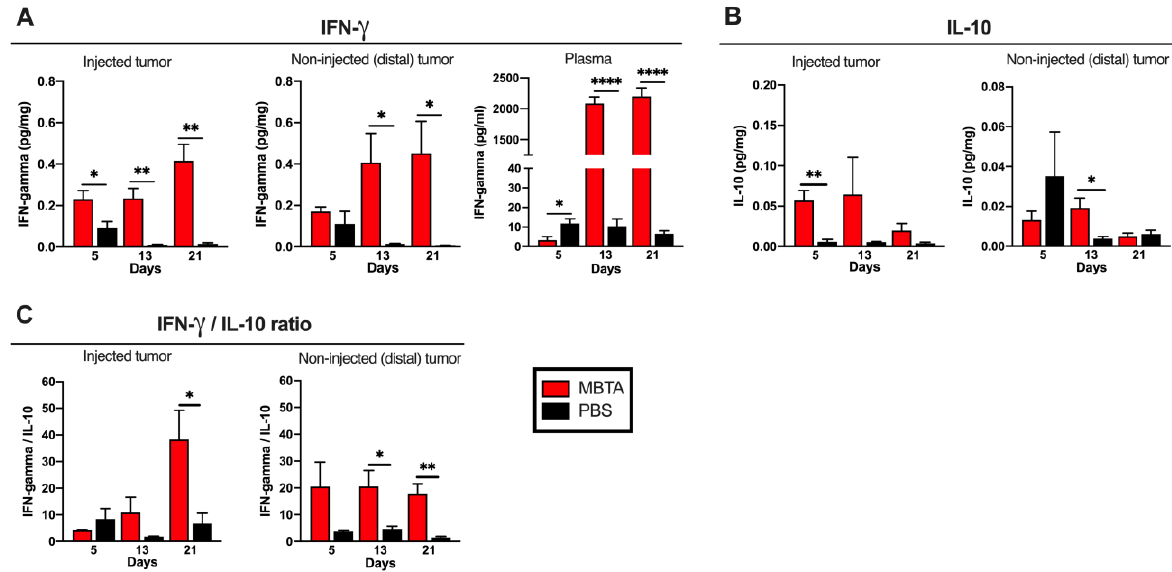
Figure 4. IFN- γ and IL-10 levels in the injected and distal tumors. ( A ) IFN- γ levels and ( B ) IL-10 levels from tumor samples measured by ELISA. ( C ) IFN- γ /IL-10 ratio in tumors ( n = 5 per group/day) (* p < 0.05, ** p < 0.01, **** p < 0.0001).